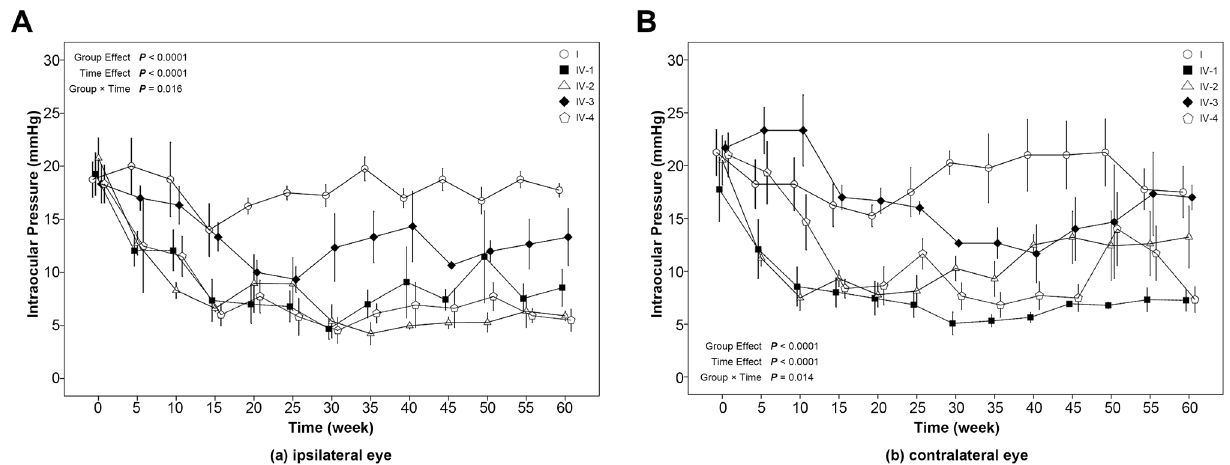
Figure 4. The effects of unilateral injection of the d opioid receptor agonist, DPDPE. into the ARC on intraocular pressure for the ipsilateral eye (a) and the contralateral eye (b). The error-bar (mean 6 SE) of each group was located at time points of 0, 5, 10, 15, 20, 25, 30, 35, 40, 45, 50, 55 and 60 minutes. A slight separation was made for error-bars at the same time point to avoid overlapping. I, control group; IV- 1, 2 m mol/ m g DPDPE group; IV-2, 4 m mol/ m l DPDPE group; IV-3, subconjunctival naloxone + 2 m mol/ m g DPDPE group; IV-4, subconjunctival saline + 2 m mol/ m g DPDPE group.